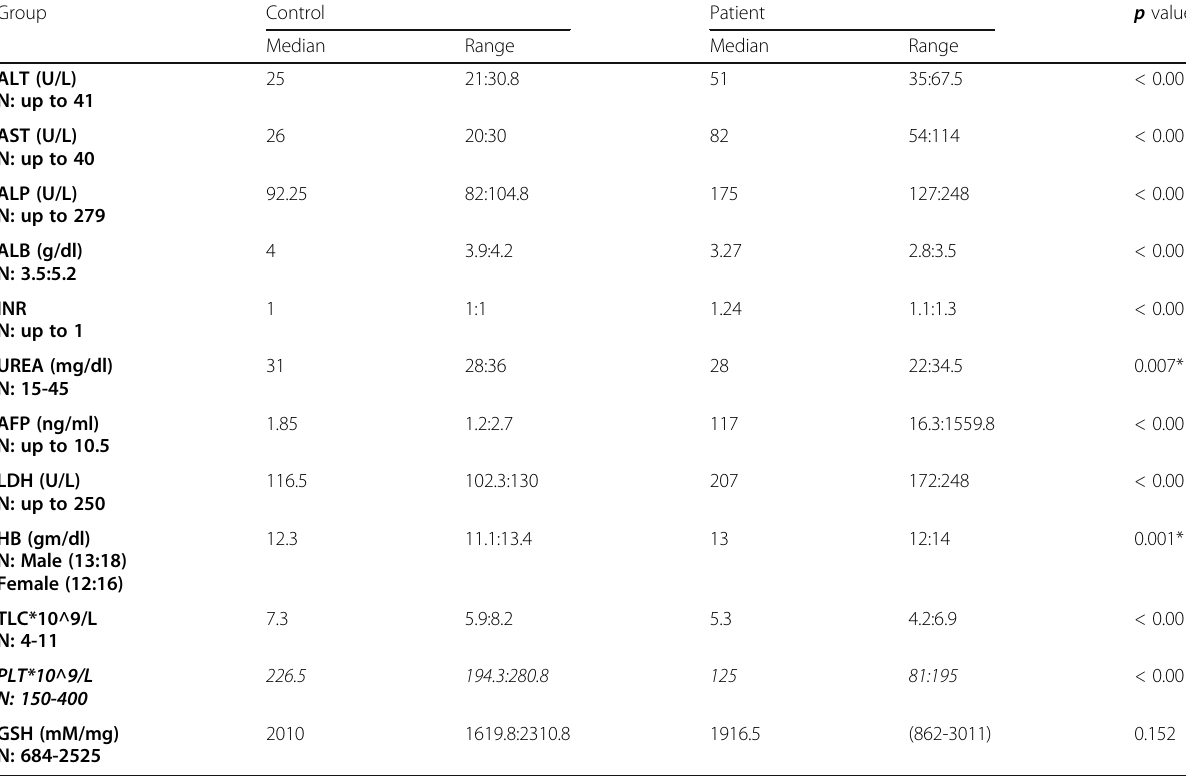
Table 4 Comparison between the HCC and the normal control groups as regards different laboratory markers and plasma GSH Group Control Patient